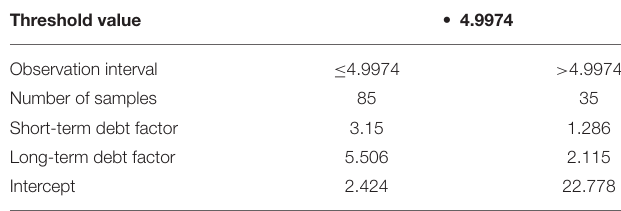
TABLE 3 | Threshold regression test